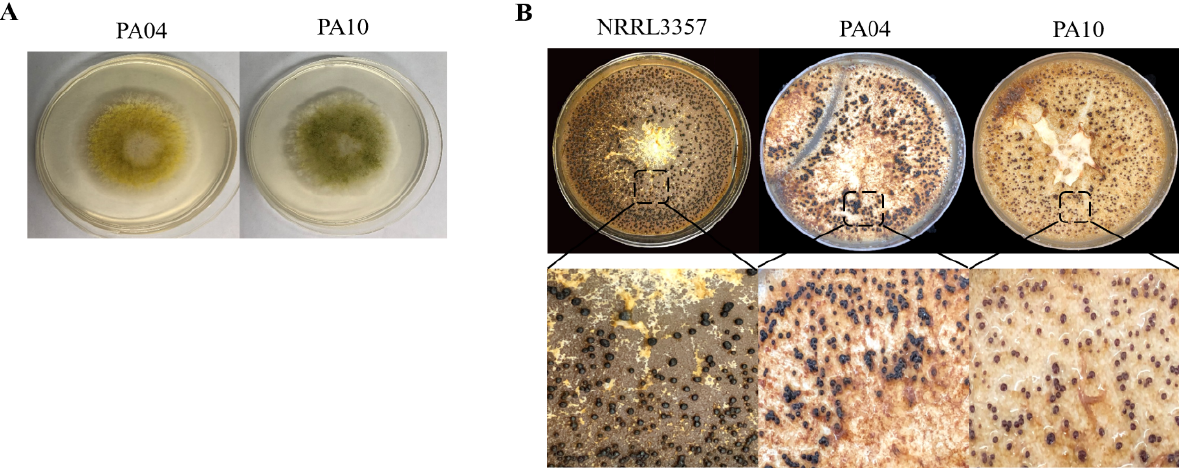
Figure 1. Aspergillus flavus PA04 and PA10 colonies incubated on Wickerham medium at 30 ◦ C for 5 d ( A ) and sclerotia from cultures incubated at 30 ◦ C for 14 d ( B